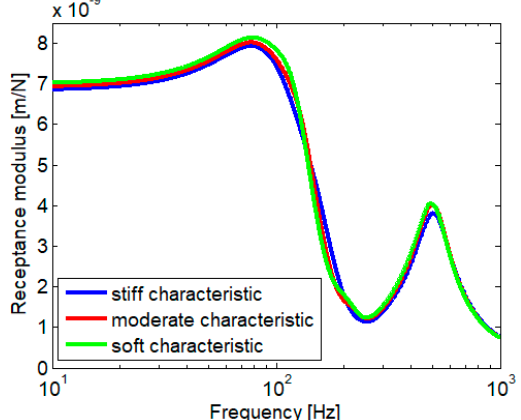
Figure 15. Rail receptance for the damped case.